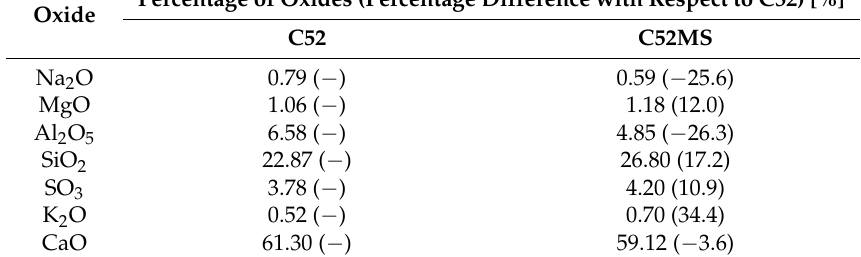
Table 5. Composition of the cement pastes tested after the thermal interaction, together with a percentage difference in the mass content of individual components, with respect to the C52 sample.